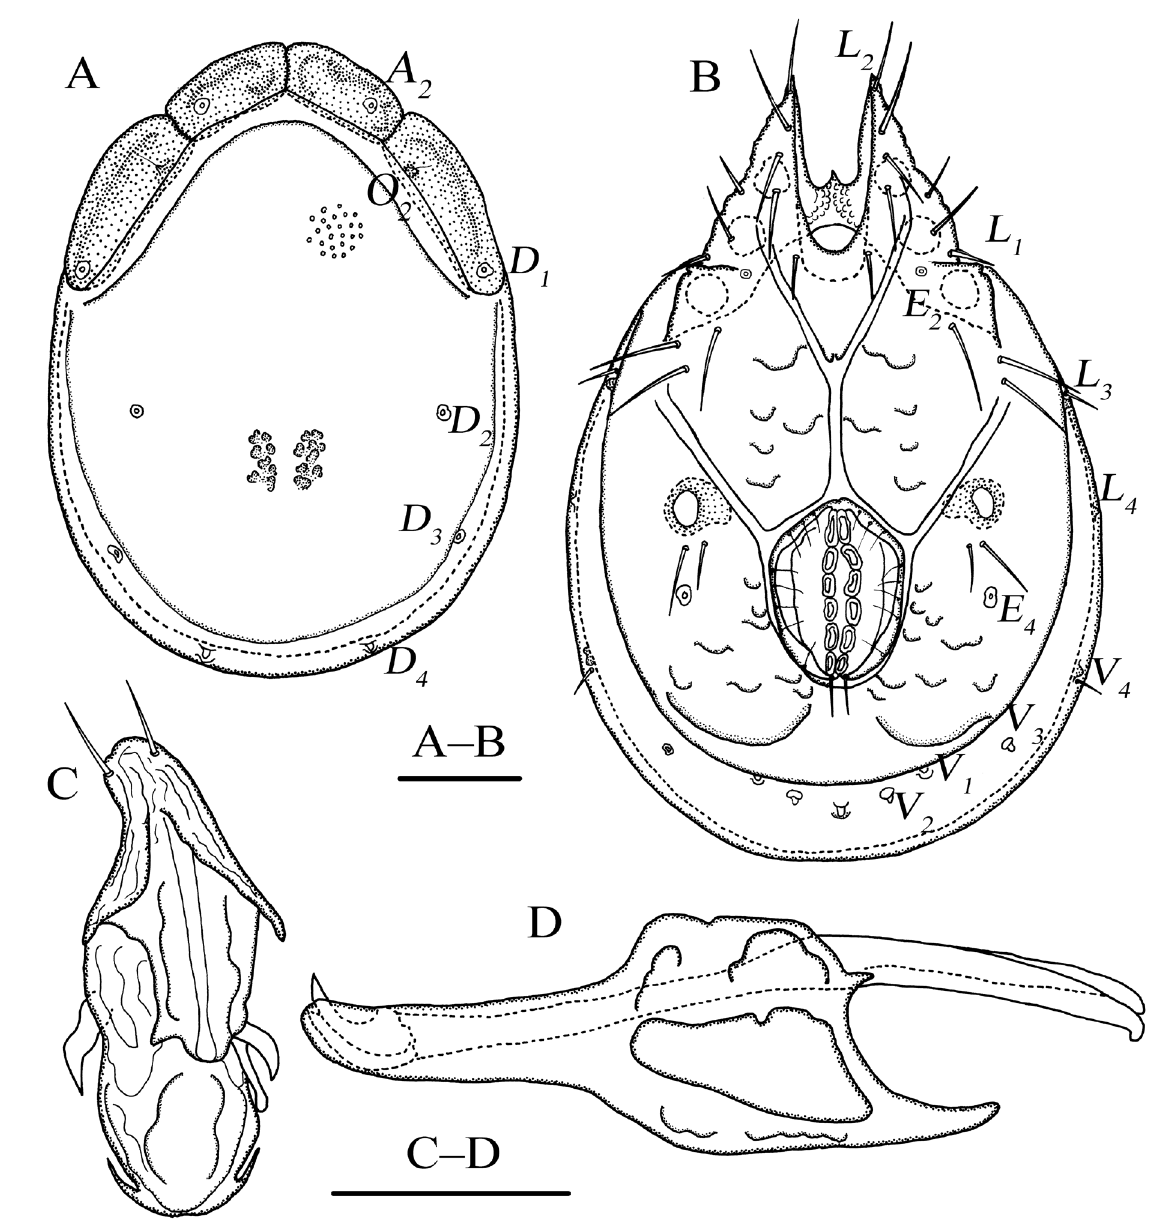
Fig. 5. Torrenticola spinextension Gu & Guo sp. nov., ♂ , holotype (FJ-TO-20180804). A . Dorsal view. B . Ventral view. C . Ejaculatory complex. D . Infracapitulum and chelicera. Scale bars = 100